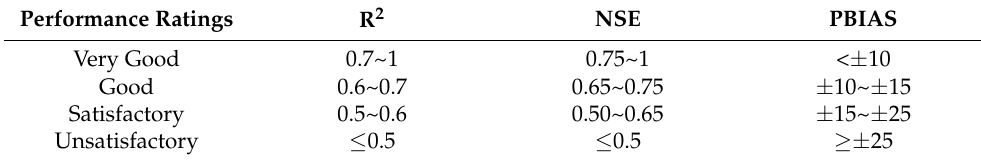
Table 3. The statistical threshold values used for interpreting model